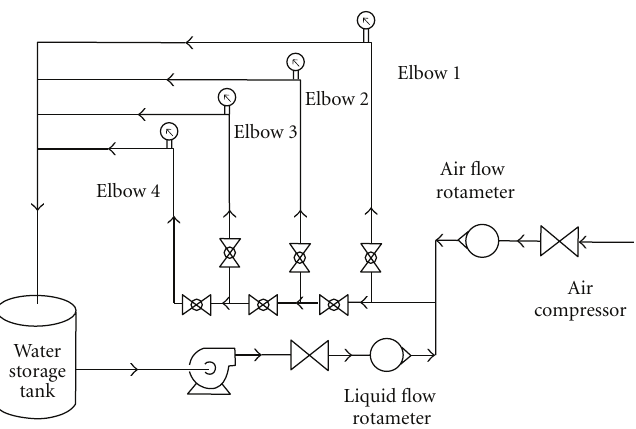
Figure 4: Schematic of the experimental test